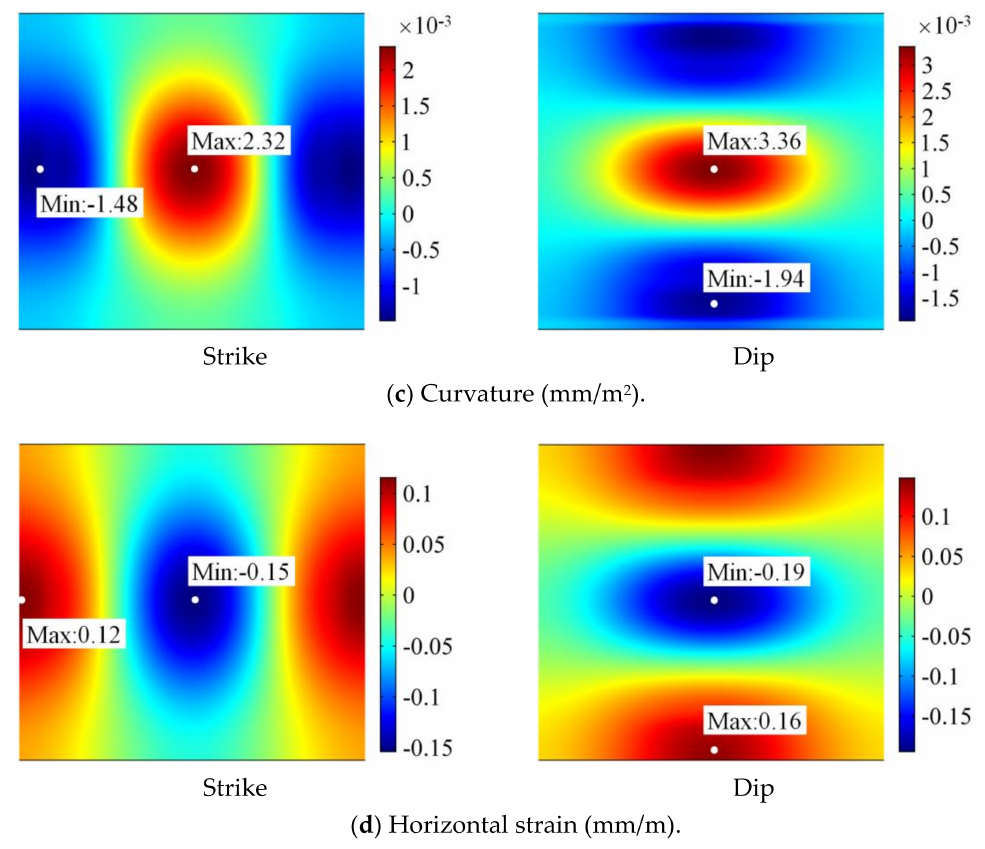
Figure 14. Numerical simulation results on the horizontal displacement, tilt, curvature and horizontal strain in the strike and dip directions.